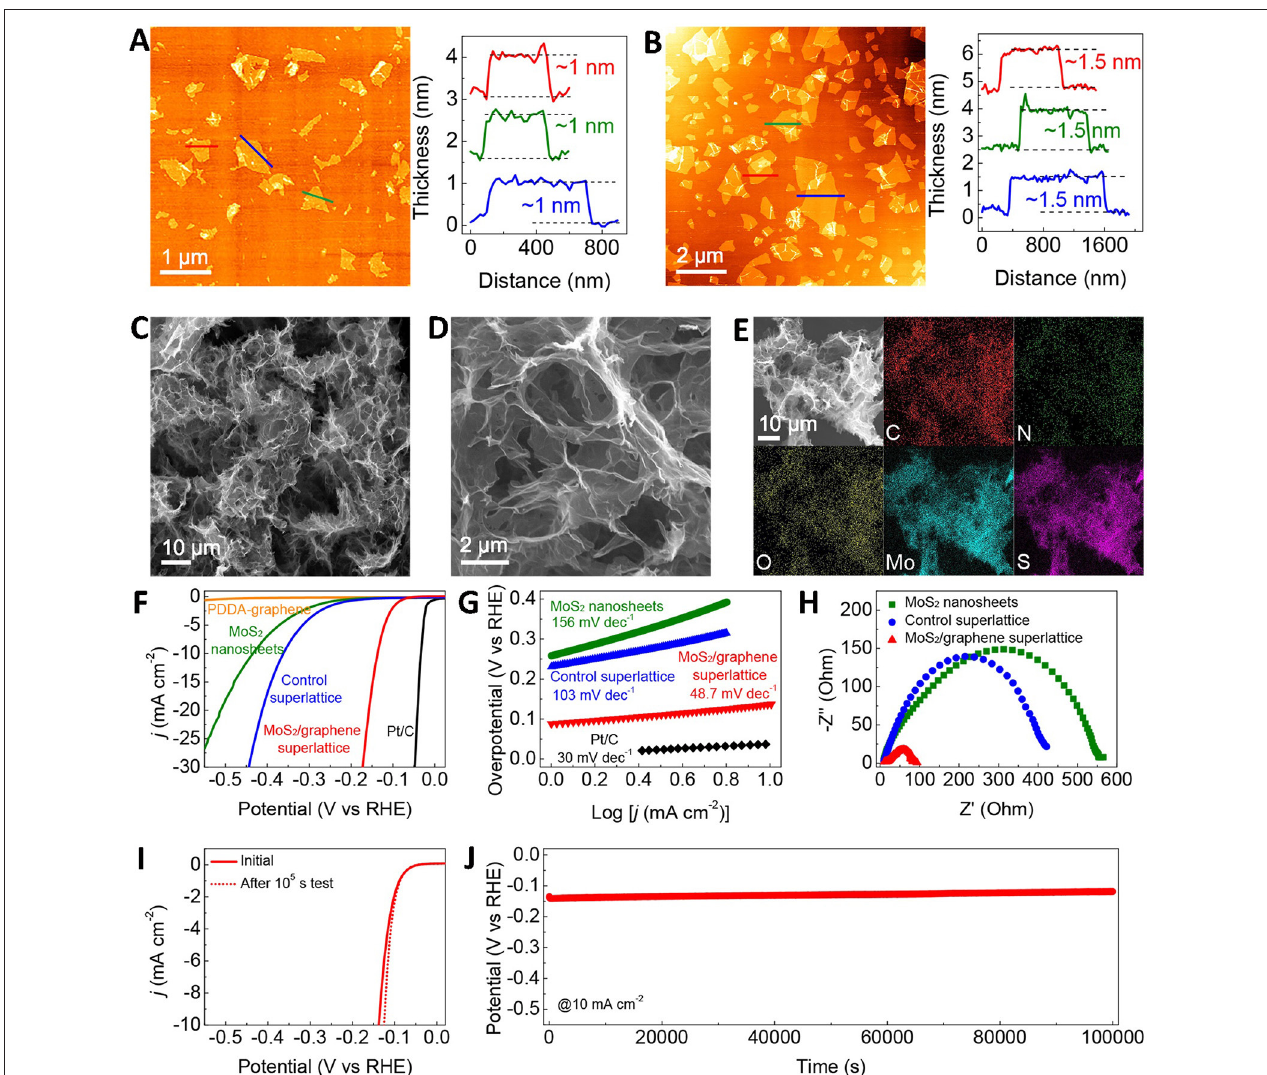
FIGURE 4 | (A) AFM images and height profiles for the exfoliated metallic MoS 2 nanosheets, (B) AFM images and height profiles for the PDDA-graphene nanosheets, (C,D) SEM images of the MoS 2 /graphene superlattice with different magnifications, (E) SEM image and corresponding elemental mapping images of the MoS 2 /graphene, (F) Polarization curves, (G) Tafel plots, (H) The EIS spectra, (I) The polarization curves of the MoS 2 /graphene superlattice before and after the 10 5 s test, (J) Long-term stability measurement (Xiong P. et al.,